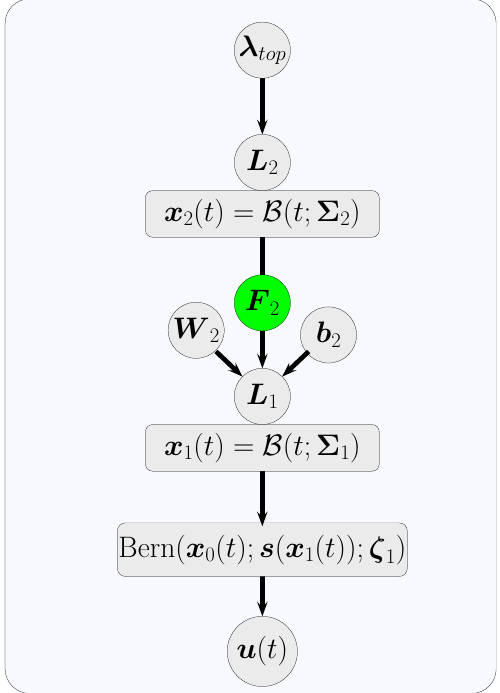
Figure 1. Overview of the hierarchical perceptual